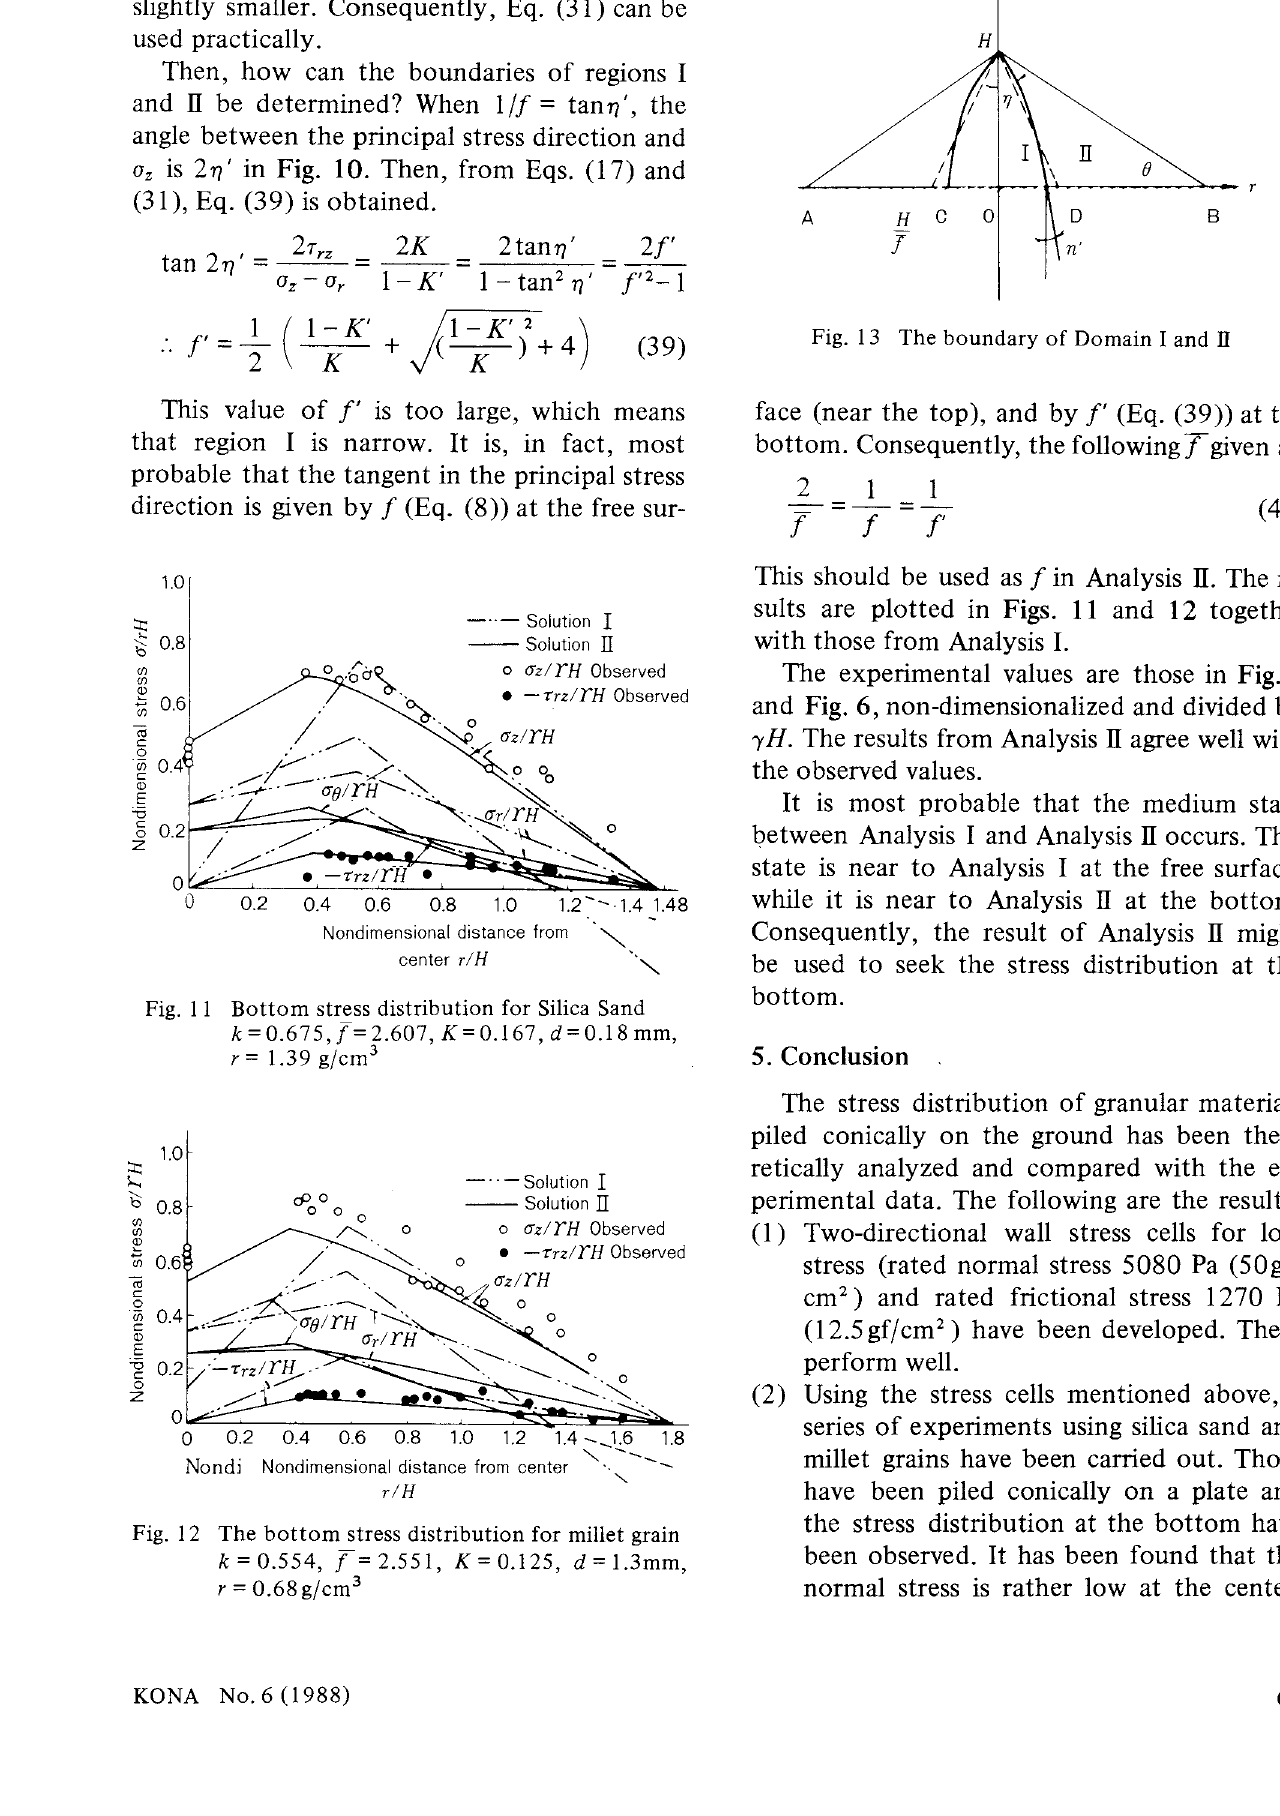
Fig. 12 The bottom stress distribution for millet grain